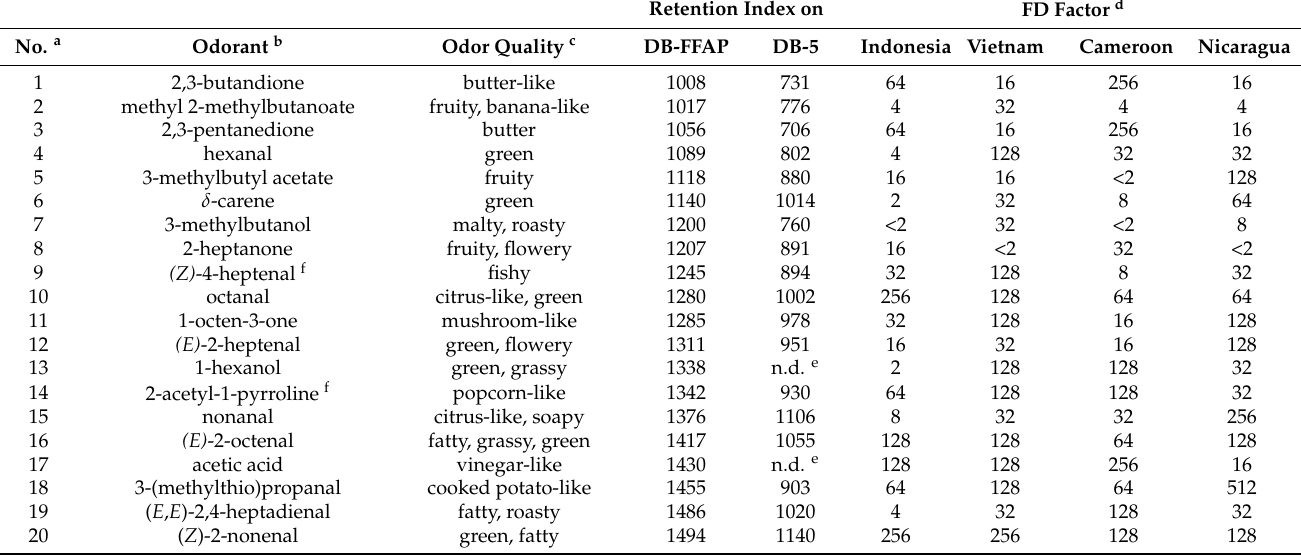
Table 1. Aroma-active compounds identified in extracts of cocoa pulps grown in Indonesia, Vietnam, Cameroon, and